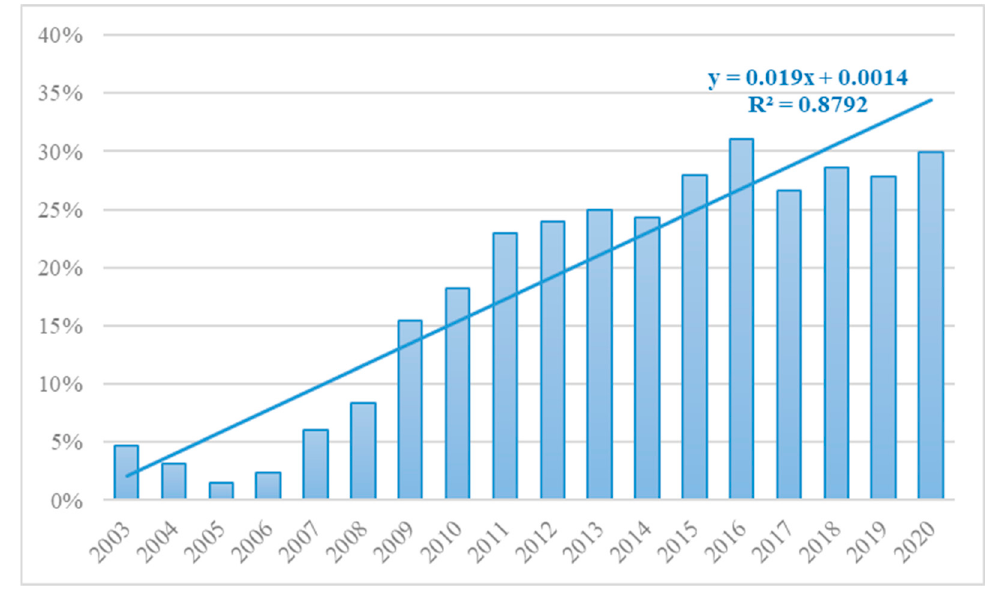
Figure 6. Ratio of liabilities to the annual budget revenues for 2003–2020 (in %) for the city of Bytom. Source: own elaboration.